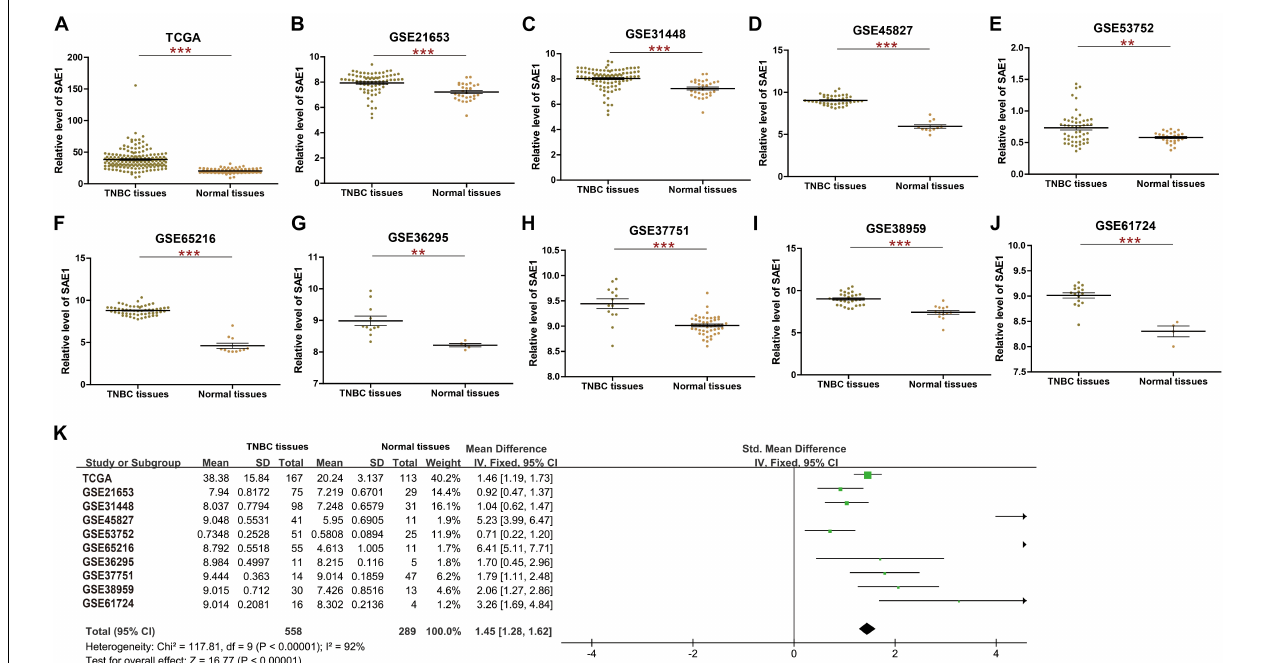
FIGURE 1 | The mRNA expression of SAE1 in TNBC. (A) The mRNA expression of SAE1 for TNBC patients in TCGA database. (B–I) The mRNA expression of SAE1 for TNBC patients in GSE21653 (B) , GSE31448 (C) , GSE45827 (D) , GSE53752 (E) , GSE65216 (F) , GSE36295 (G) , GSE37751 (H) , GSE38959 (I) , and GSE6172 (J) . Meta-analysis of SAE1 expression in TNBC patients (K) . ** p < 0.01; *** p < 0.001.